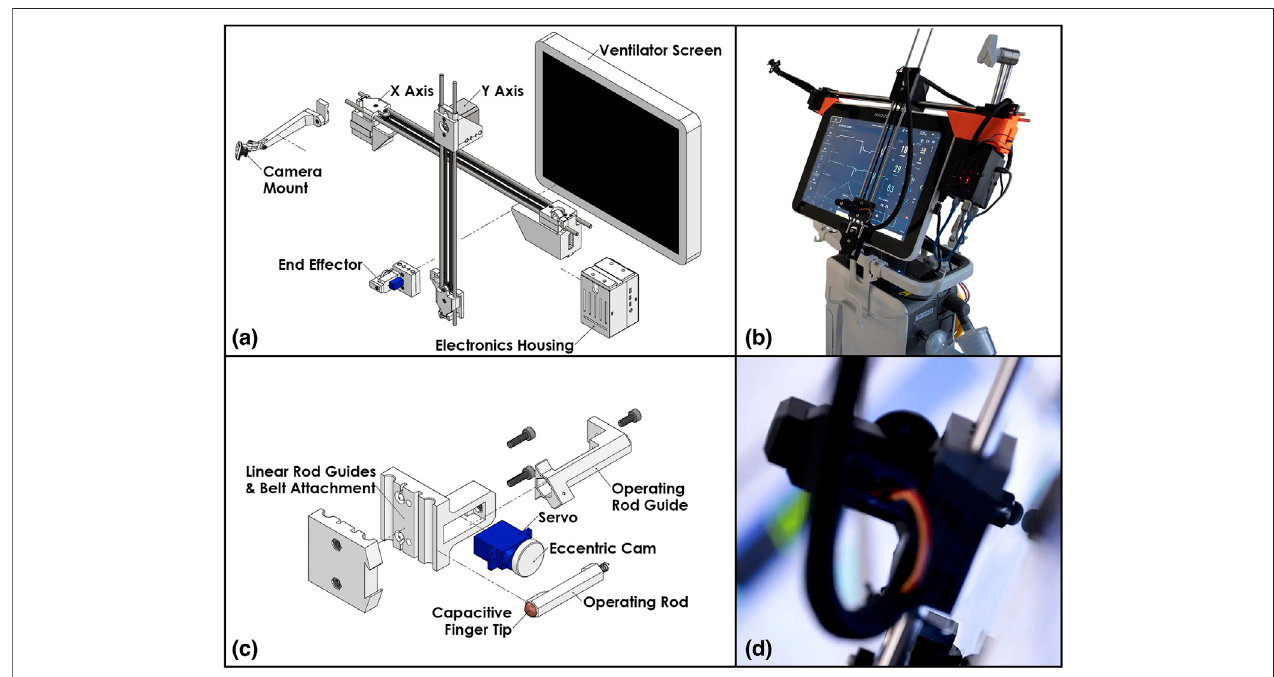
FIGURE 2 | The patient side robotic ventilator controller: (A) exploded view drawing of the robotic system, (B) photo of the robotic system installed on a Maquet Servo-U ventilator, (C) detailed exploded view drawing of the end effector assembly, (D) close-up photo of the end effector operating a Servo-U ventilator.